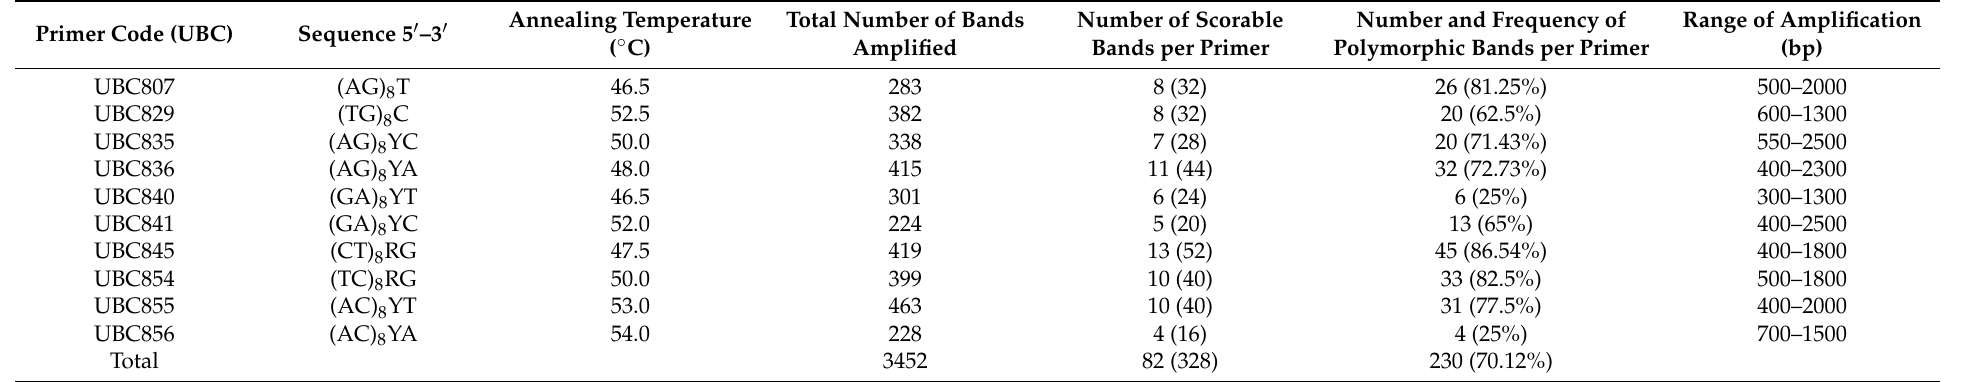
Table 7. Primers used in the ISSR polymorphism analysis, number and size of amplified fragments of Orthosiphon stamineus plantlets exposed to abiotic